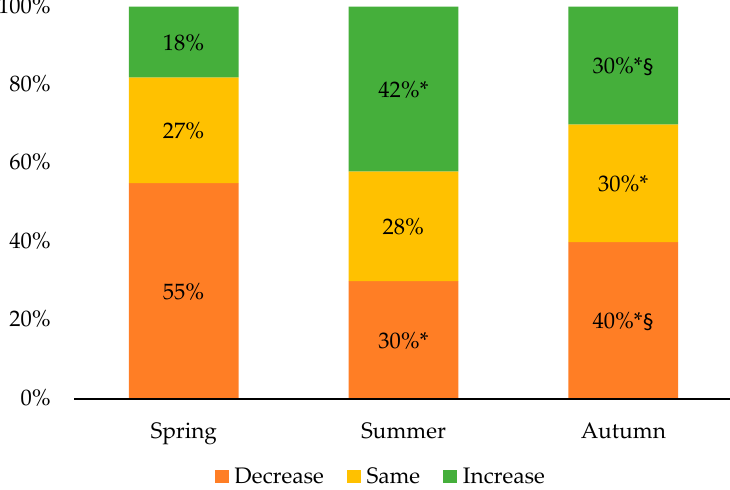
Figure 2. Evolution of physical activity practice compared to the winter 2020. * Significantly different from the spring; § Significantly different from the summer; p < 0.01.